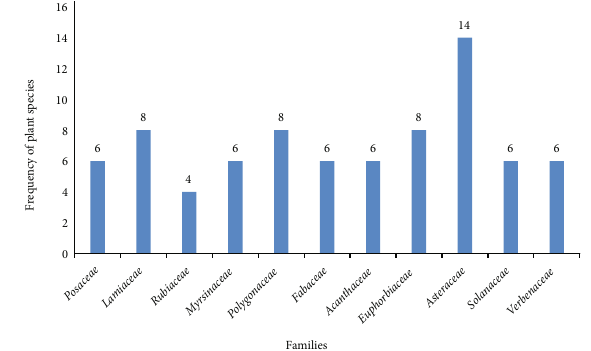
Figure 2: Frequently used families for the treatment of gastrointestinal